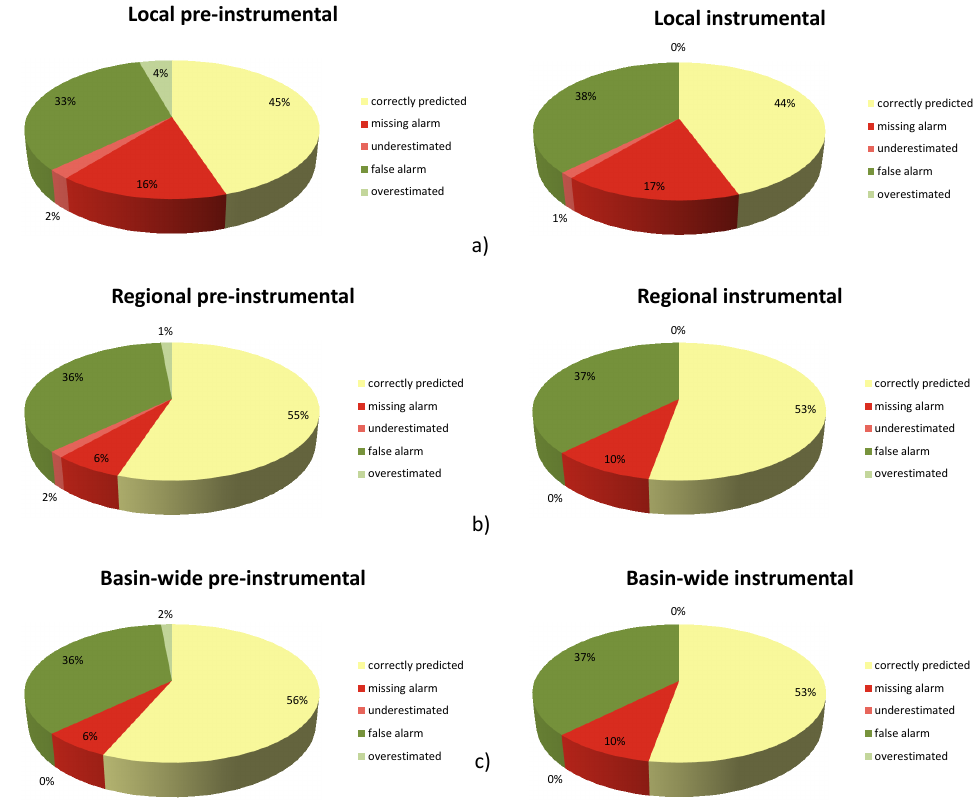
Fig. 6. Performances of the DM at local (a) , regional (b) and basin-wide (c) level: comparison between pre-instrumental (1600–1899) and instrumental (1900 to present day) data. Frequencies of the various categories do not vary much from one subset to the other and are also similar to the one of the global dataset shown in Fig.